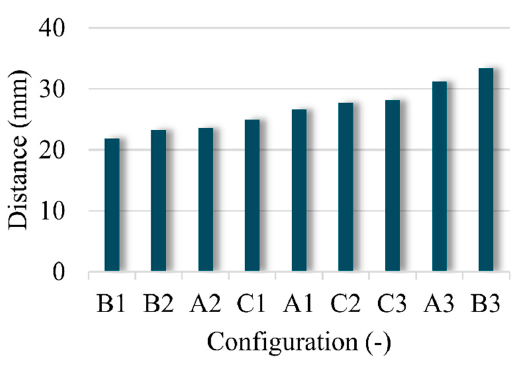
Figure 11. The distortion tendencies of five areas.